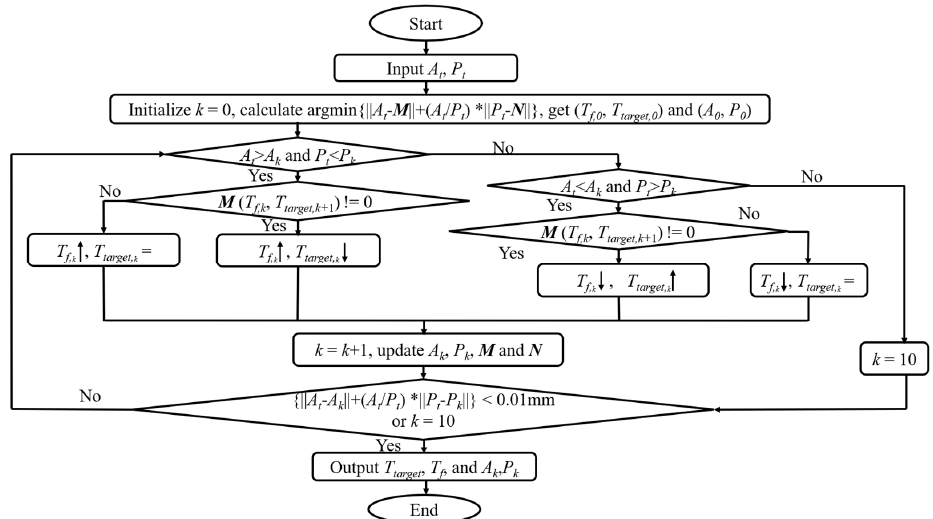
Figure 10. Algorithm flowchart determining T target and T f for desired ablation depth ( A t ) and protection depth ( P t ) . M and N are the functions of ablation depth and protection depth change with T target and T f , respectively. k is the number of iterations. A k , P k , T f,k , and T target,k are the k th calculations of A , P , T f , and T target .